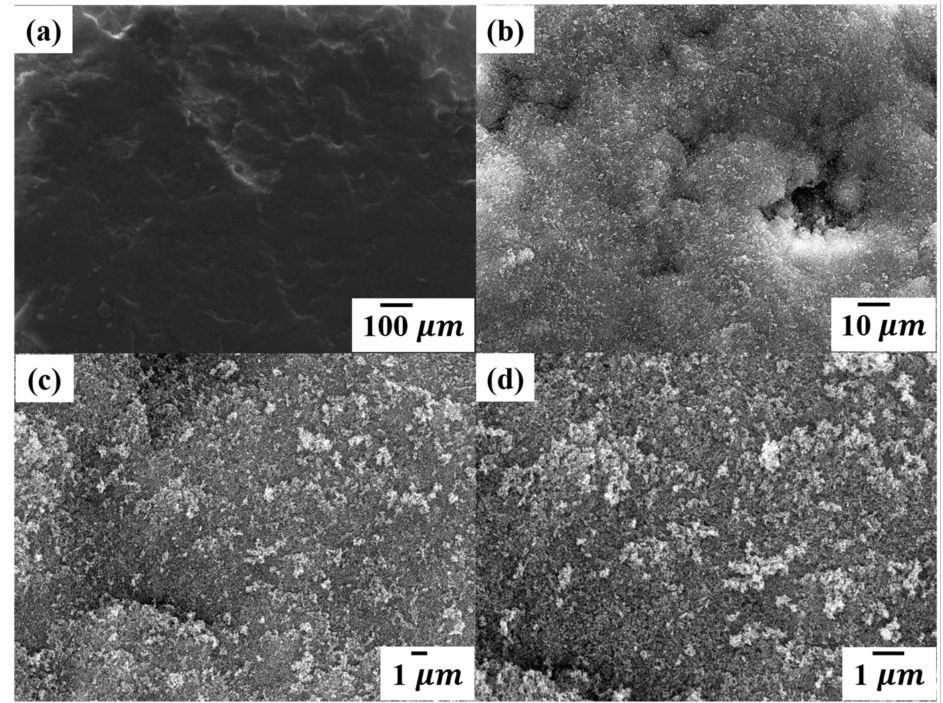
Figure 4. FE-SEM images of the fabricated PP/SNPs coated films at different magnifications ( a – d ). Additionally, the cross section of the fabricated superhydrophobic PP/SNPs coated films were observed to evaluate the thickness of the films. To determine the effect of SNP weight difference, the PP/SNPs coated films with different relative weight ratios of SNPs, such as 11%, 33%, and 100%, were evaluated. The result showed that different thicknesses of fabricated superhydrophobic coated films were obtained according to the different relative weight ratio of SNPs, as shown in Figure 5. The results showed that the thickness of the coated film with relative SNP weight ratios of 11%, 33%, and 100% were from 13 to 25 µ m, 13 to 29 µ m, and 15 to 34 µ m, respectively. As the weight of SNPs increased, the overall thickness of the coated film increased.